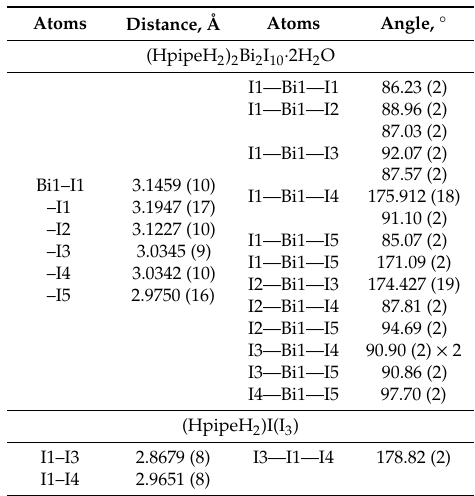
Table 2. Selected Interatomic Distances and Angles in the Anionic Part of the Crystal Structures